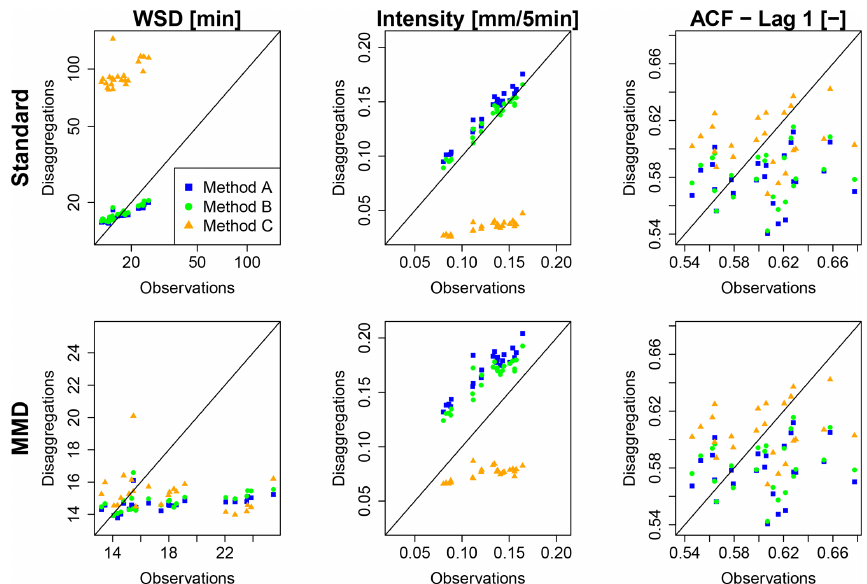
Figure 7. Rainfall characteristics of observed and disaggregated time series as x - y plots for all 24 stations (WSD = wet spell duration, ACF = autocorrelation function; note the different scales for wet spell duration).